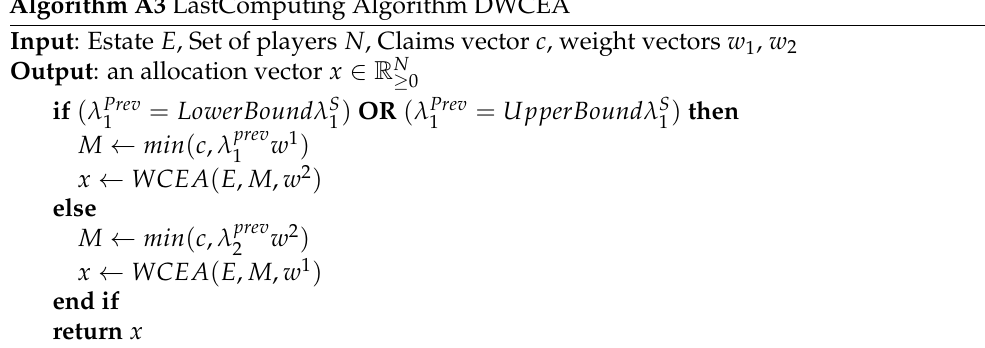
Algorithm A3 LastComputing Algorithm